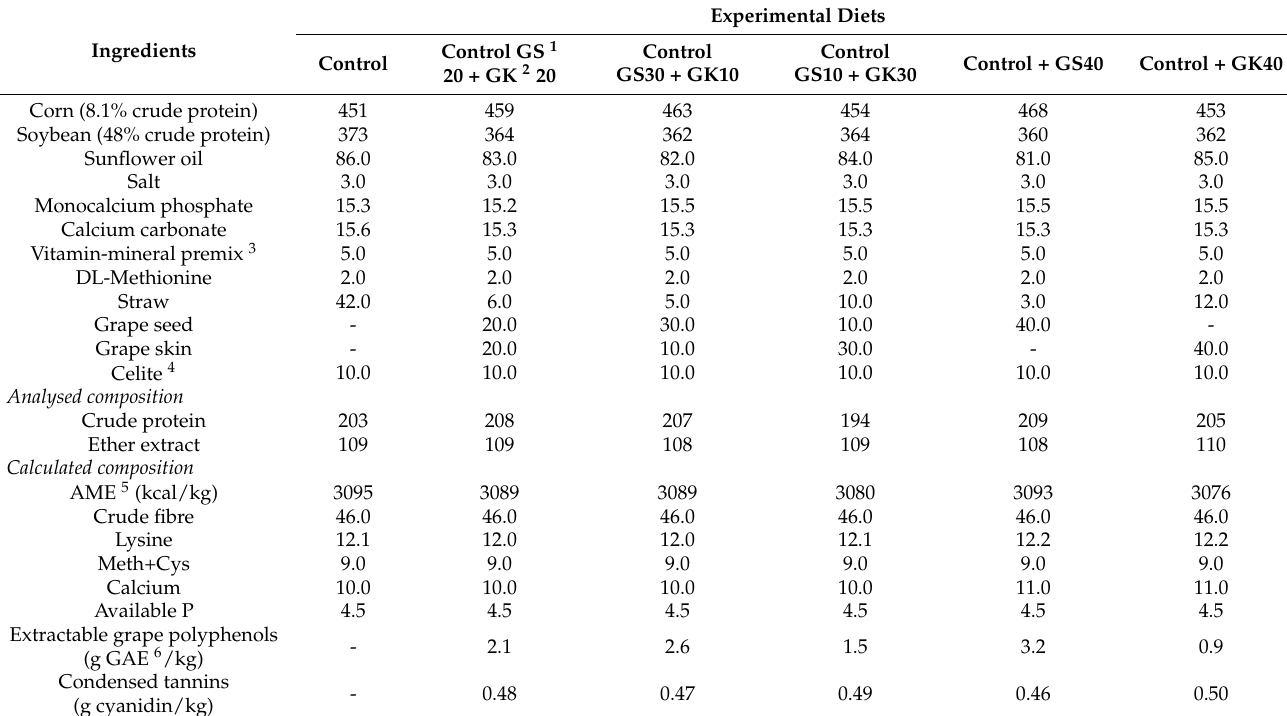
Table 1. Ingredients and nutrient composition of experimental diets (g/kg as